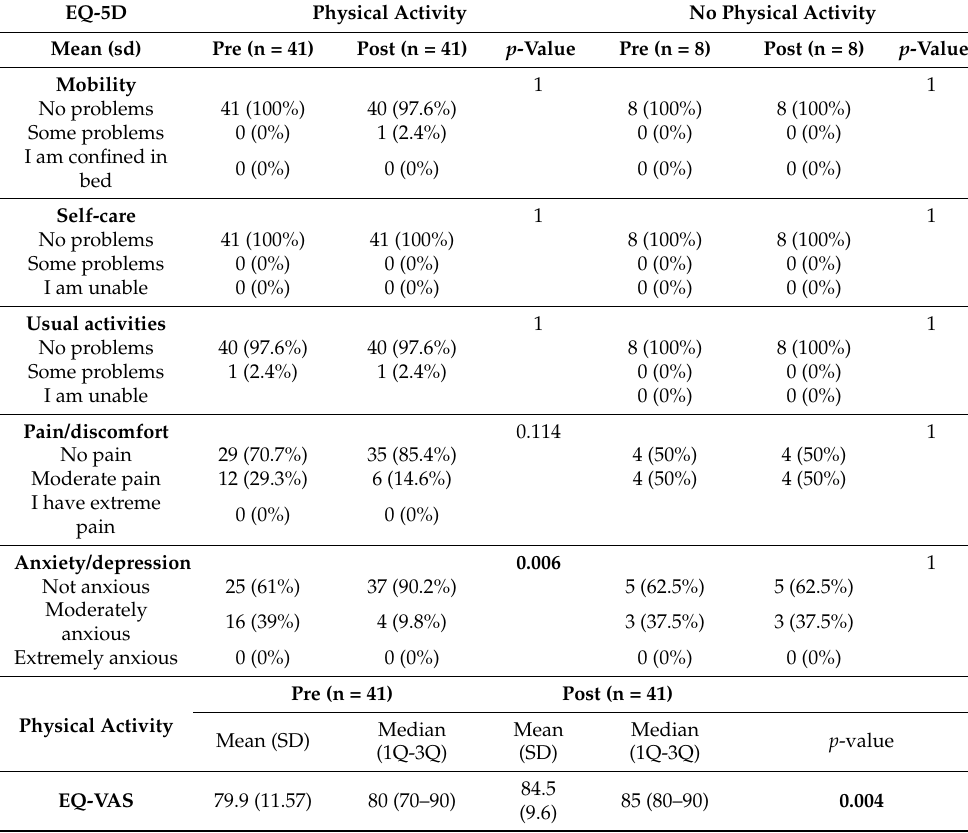
Table 5. Health status by EQ-5D-3L of individual at 3-week